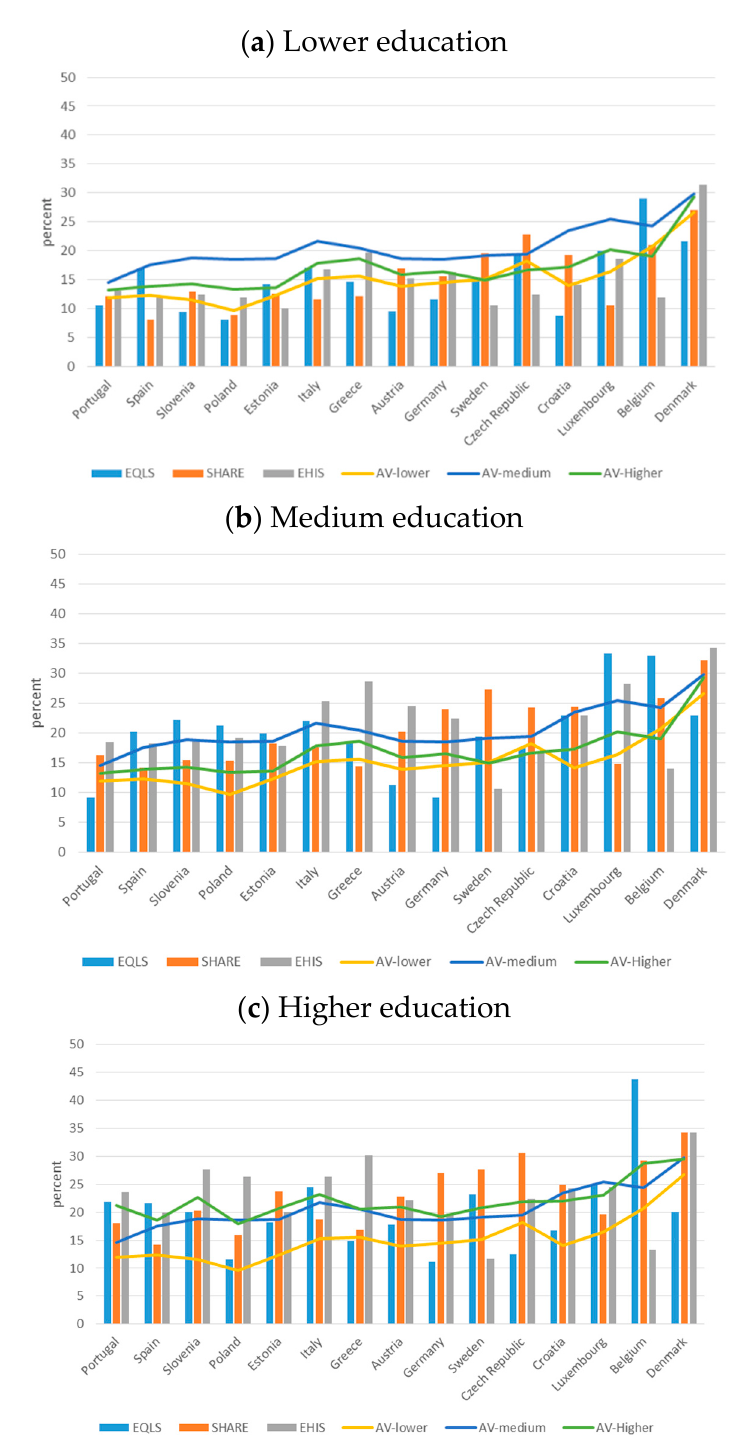
Figure 7. Informal Caregivers over 50, by education level (weighted) (percent) ( a ) lower education; ( b )medium education; ( c ) higher education. EQLS = European Quality of Life Survey; SHARE = Survey of Health, Ageing and Retirement in Europe; EHIS = European Health Interview Survey; AV=Average